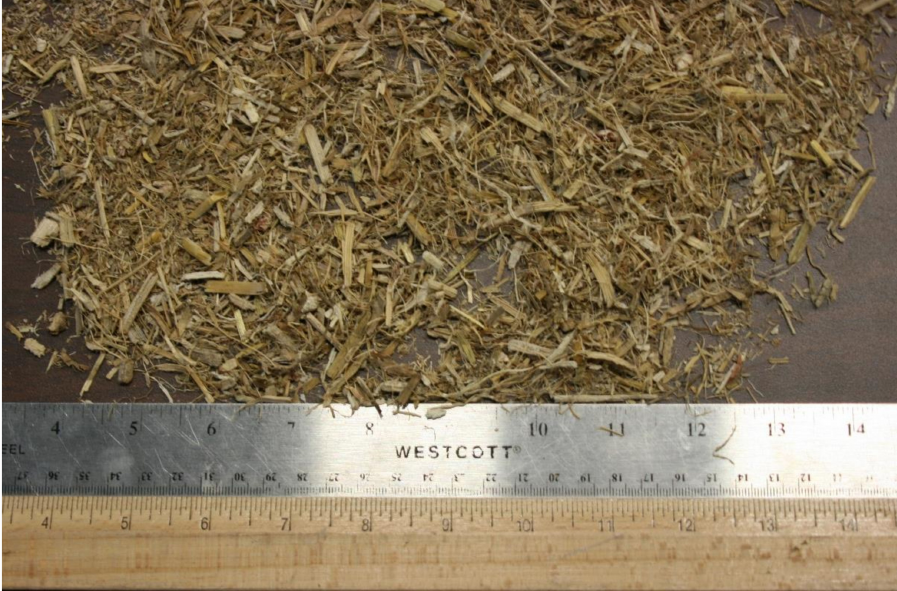
Figure 2. The corn stover after Stage-1